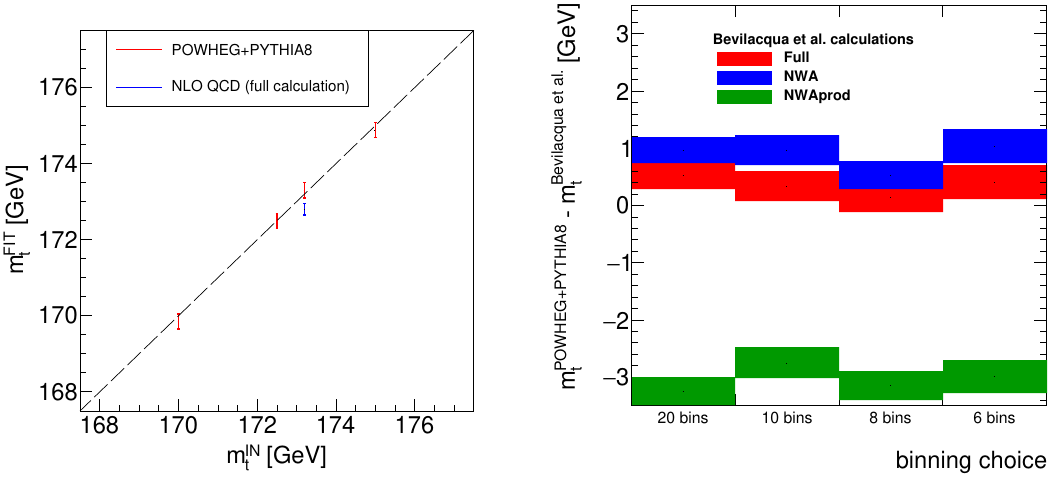
Figure 38 . Linearity of the fit (left) and differences between top-quark mass values extracted from R distributions calculated with different approaches (right). Different binning choices have been tested: 20 and 10 bins of equal size (respectively with widths 0.05 and 0.1), the 6 bins choice of refs. [2, 3] and the 8 bins choice of ref. [5]. Results are found to be consistent across the binning